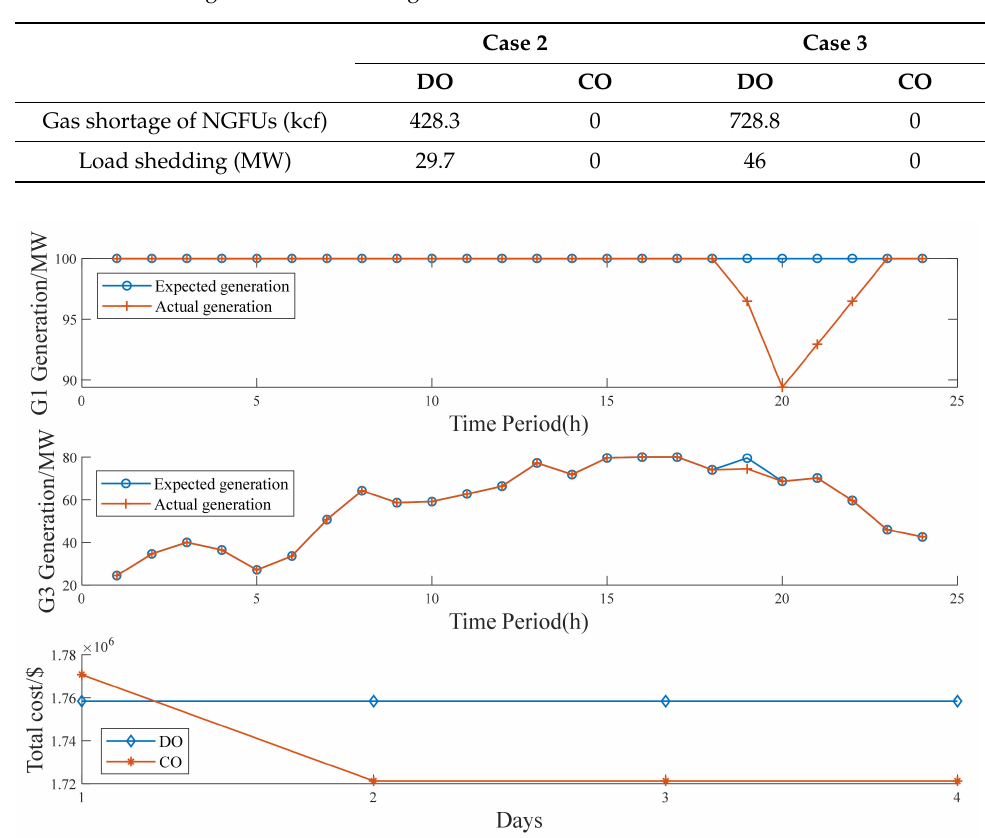
Table 5. Gas shortage and load shedding in DO.